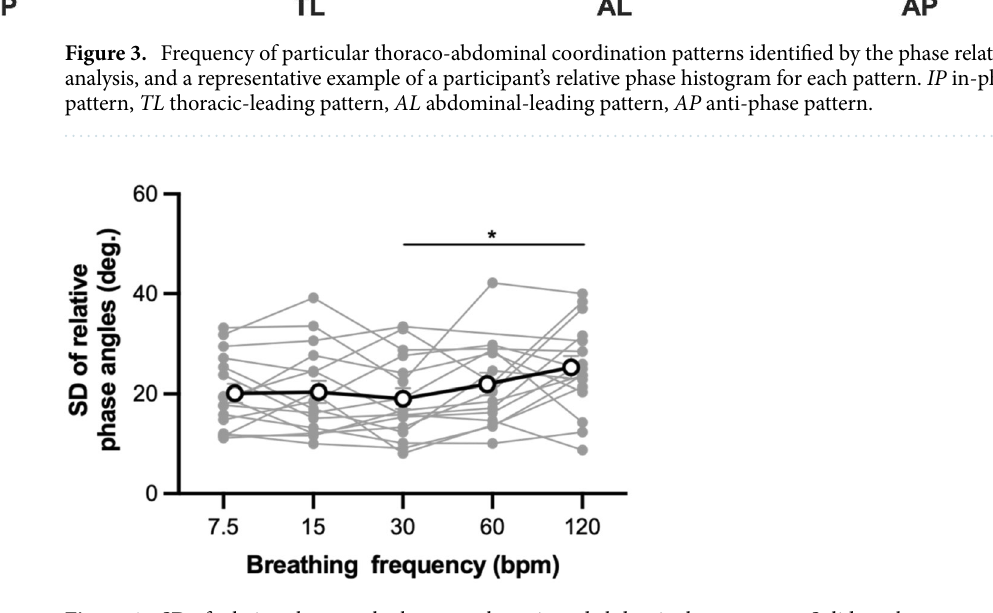
Figure 4. SD of relative phase angles between thoracic and abdominal movements. Solid markers represent individual participants. Open circles indicate mean value across participants. Vertical bars represent between- subject standard error. * p <